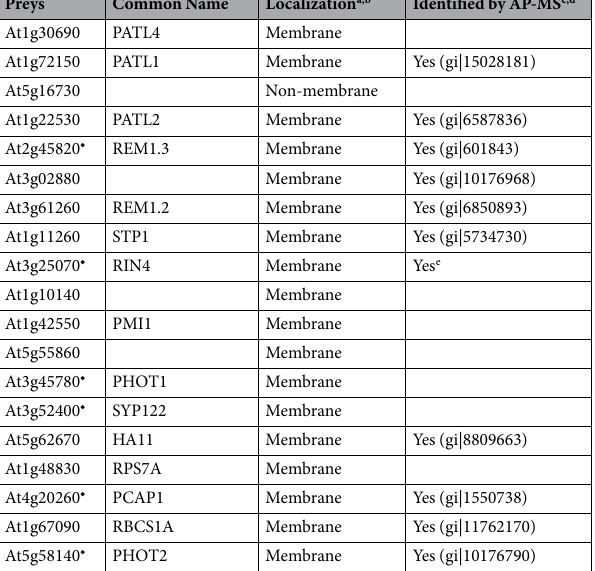
protocol described above for protein localization with the addition of 1% of plant protease inhibitor cocktail (Sigma no. P9599) to the extraction buffer (all buffers and wash solutions were made with MS-grade H 2 O). The insoluble and soluble fractions were combined before affinity purifications. The combined fractions were run through Amicon Ultra-4 centrifugal filter units with Ultracel-10 membrane (EMD Millipore no. UFC8010) and washed four times with 4 mL of extraction buffer without detergents to remove excess biotin in lysates. Concentrated 1 mL of supernatant (12 mg of protein) with additional 1 mM DTT and 1% protease inhibitor cock- tail (Sigma no. P9599) was used for affinity purification with 30 μ L of prewashed 50% slurry mix of streptavidin sepharose beads (GE healthcare no. 17511301) overnight in a rotator at 4 °C. After affinity purification, super- natant with leftover proteins was used as unbound fraction. Streptavidin beads were washed once in extraction buffer without detergents (1 mL per wash), once in SDS buffer (2% SDS, 50 mM Tris pH 7.5) two more times in extraction buffer (1 mL per wash) and three times in 50 mM ammonium bicarbonate (ABC; pH 8.0). An aliquot of the beads was saved for western blots as the bound fraction. Note that all buffers used for affinity purification and on bead digest are made in HPLC grade water. On bead digestion. After affinity purification and removal of all washing buffer, beads were resuspended in 200 μ L of 50 mM ABC (pH 8.0) with 1 μ g of trypsin (Sigma no. T6567) added and incubated at 37 °C with agi- tation for four hours after which an additional 1 μ g is added and samples left agitating overnight at 37 °C. Beads are pelleted (500 g, 2 min) and the supernatant was transferred to a fresh 1.5 mL tube. The beads were rinsed with 100 μ L of MS-grade H 2 O and the rinses were combined with original supernatant. The pooled fraction was acid- ified to 2% formic acid and centrifuged at 16000 g for 5 minutes. The top 80% supernatant volume was carefully